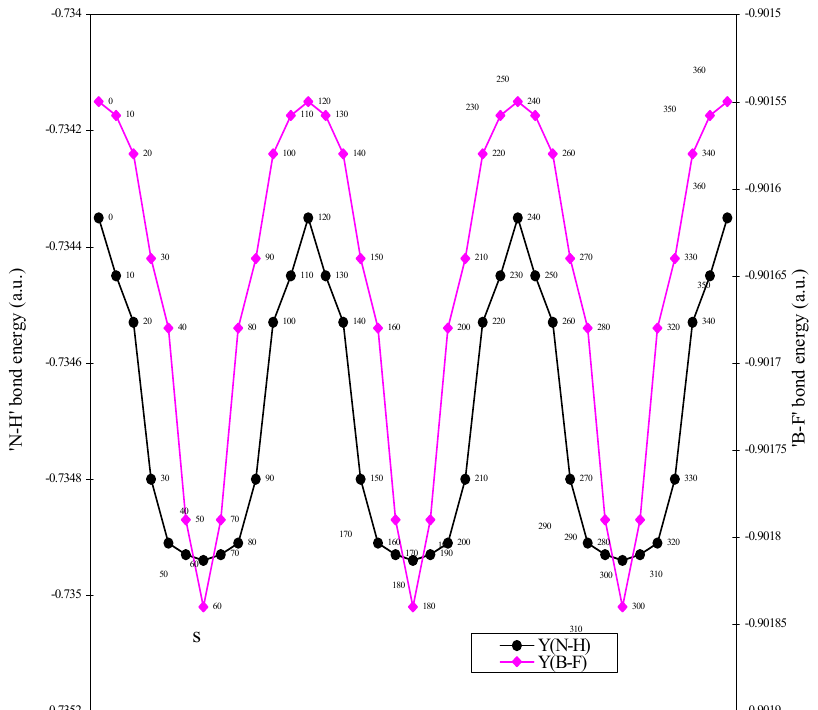
Figure 7. Plot of 'N-H' and 'B-F' two center bonded interaction energies of F system as a function of torsional angle (E-Eclipsed,